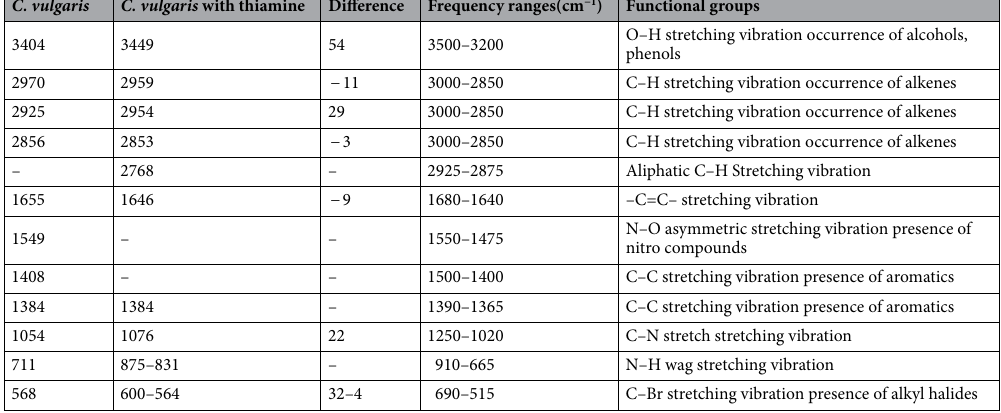
Table 5. The FT-IR frequency range and the following functional groups are present in the C. vulgaris and with